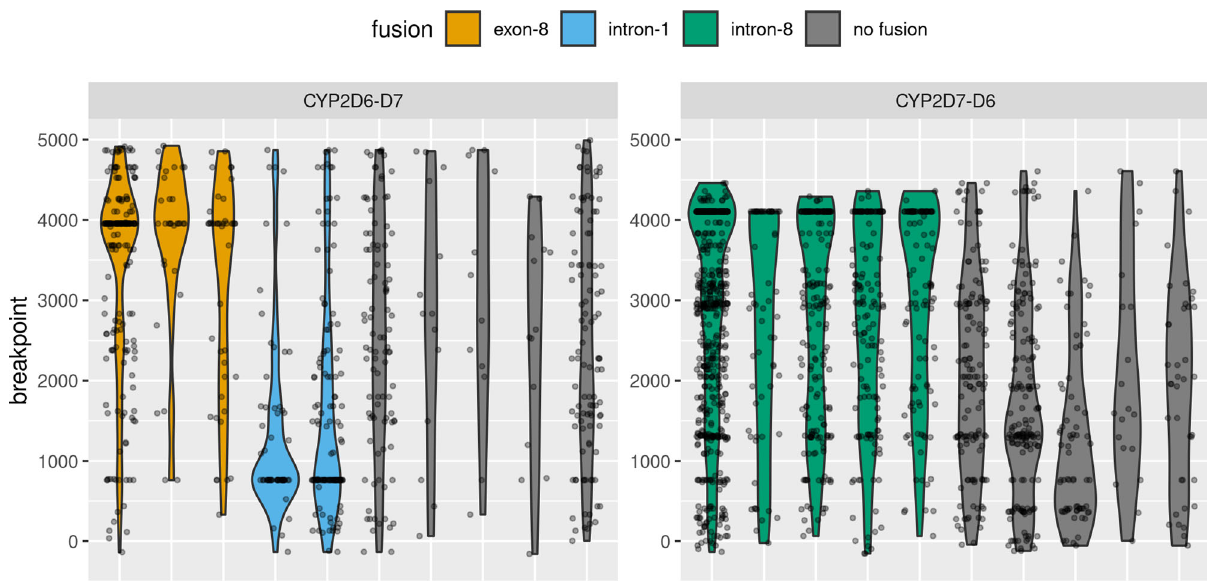
Fig. 2 Fusion detection by breakpoint clustering. Violin plots overlaid with jitter plots show the distribution of chimeric/fusion read breakpoints for a set of samples selected for illustrative purposes. Chimeric breakpoints are expected to a have a relatively uniform distribution over the length of the amplicon, while true gene fusions should be concentrated within a narrow region. Fusions are called when a suf fi cient density of breakpoints is detected (see “ Methods ” and source code for full